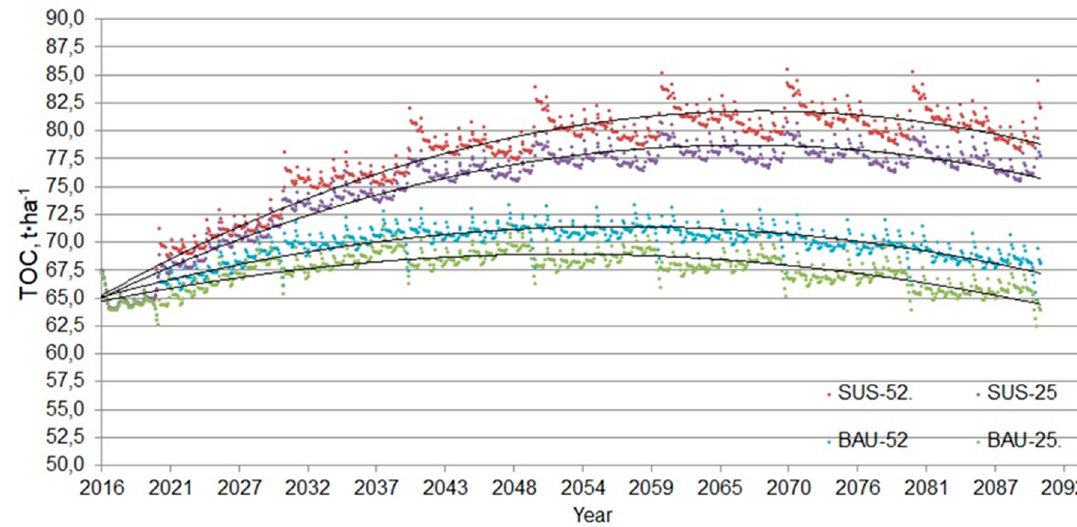
Figure 9. The dynamics of total SOC stocks for various crop rotations calculated using the RothC model for 2016–2090 in treatment 1NPK under the RCP4.5 climate scenario. The trend line is a polynomial of the second degree.